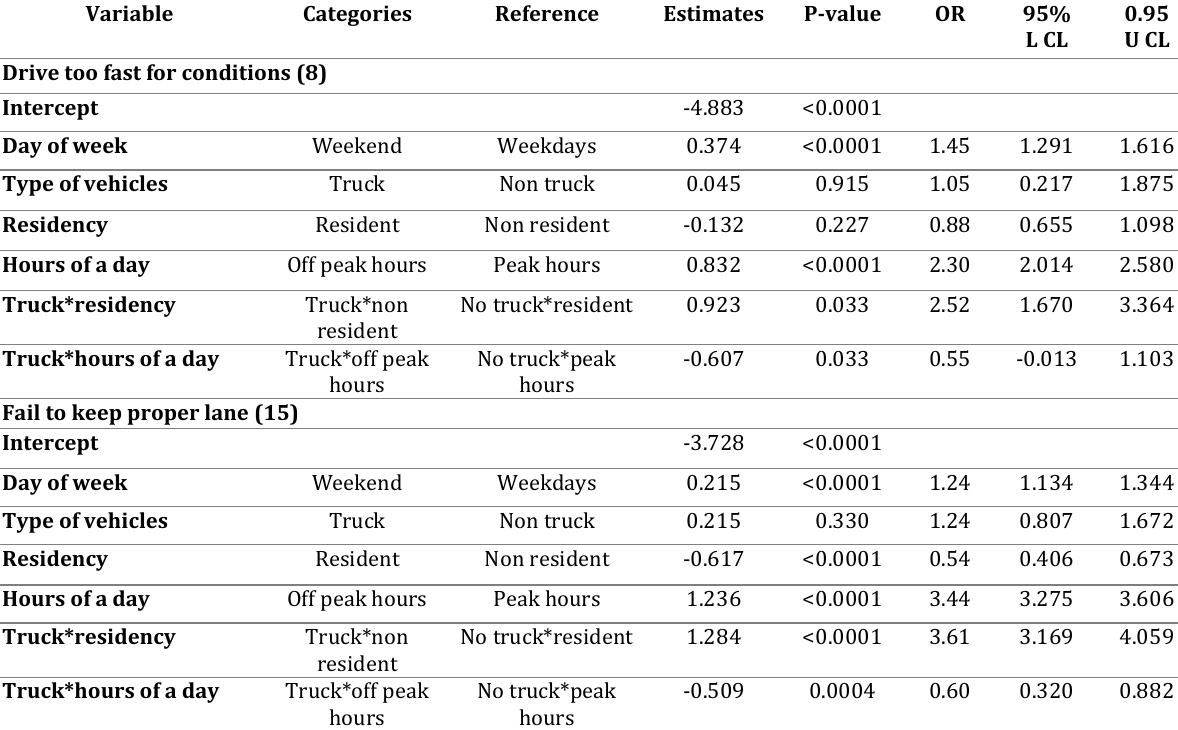
Table 3: Multinomial Logistic Regression: parameter estimates and odds ratios for different driver actions, citation